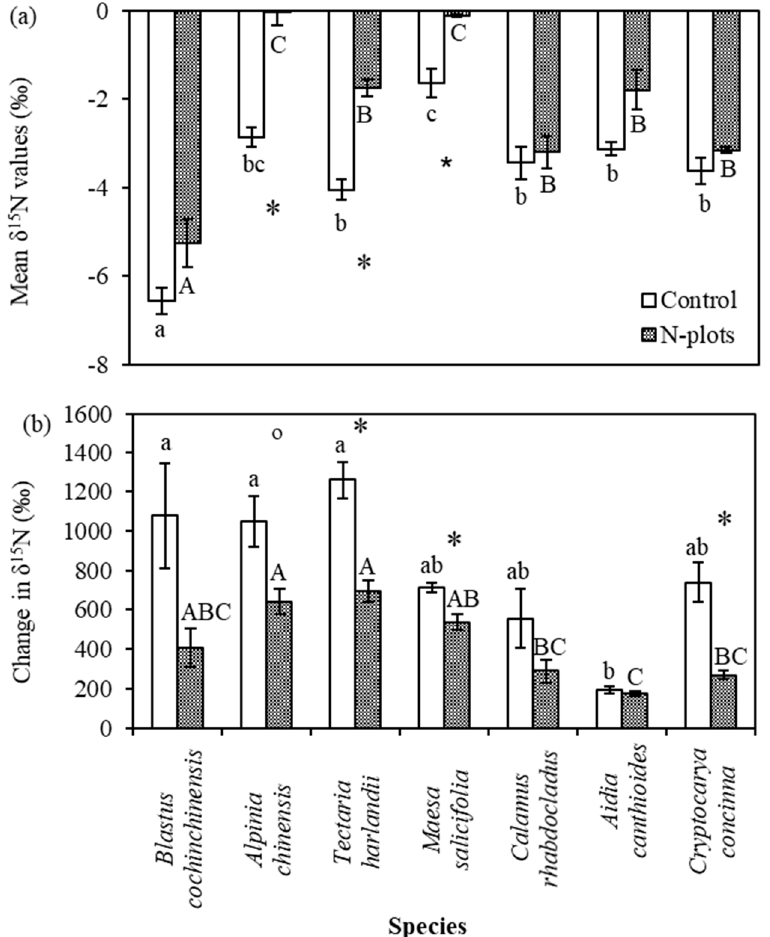
Figure 3. Leaf δ 15 N values of dominant co-occurring understory plant species in Dinghushan Biosphere Reserve (DHSBR): ( a ) natural δ 15 N abundance in control and in N-plots; and ( b ) changes in leaf δ 15 N values after one year of 15 N tracer addition in both treatments. The change in leaf δ 15 N values in ( b ) was determined by subtracting the δ 15 N found prior to the 15 N addition presented in ( a ) from the leaf δ 15 N values obtained after the one-year 15 N tracer addition in each treatment. Error bars indicate SE ( n = 3). For each graph, species means with di ff erent letters indicate significant species di ff erences ( p < 0.05) in control plots (lowercase letters) and in N-plots (uppercase letters). Significant e ff ects of N addition within species are indicated by * ( p < 0.05) and o ( p < 0.1).